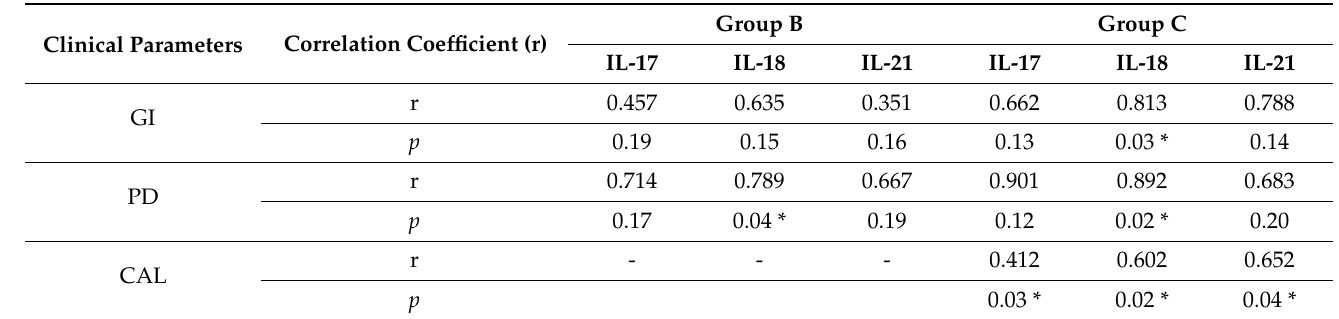
Table 3. Correlation analysis of clinical parameters (GI, PD and CAL) with interleukins (IL-17, 18 and